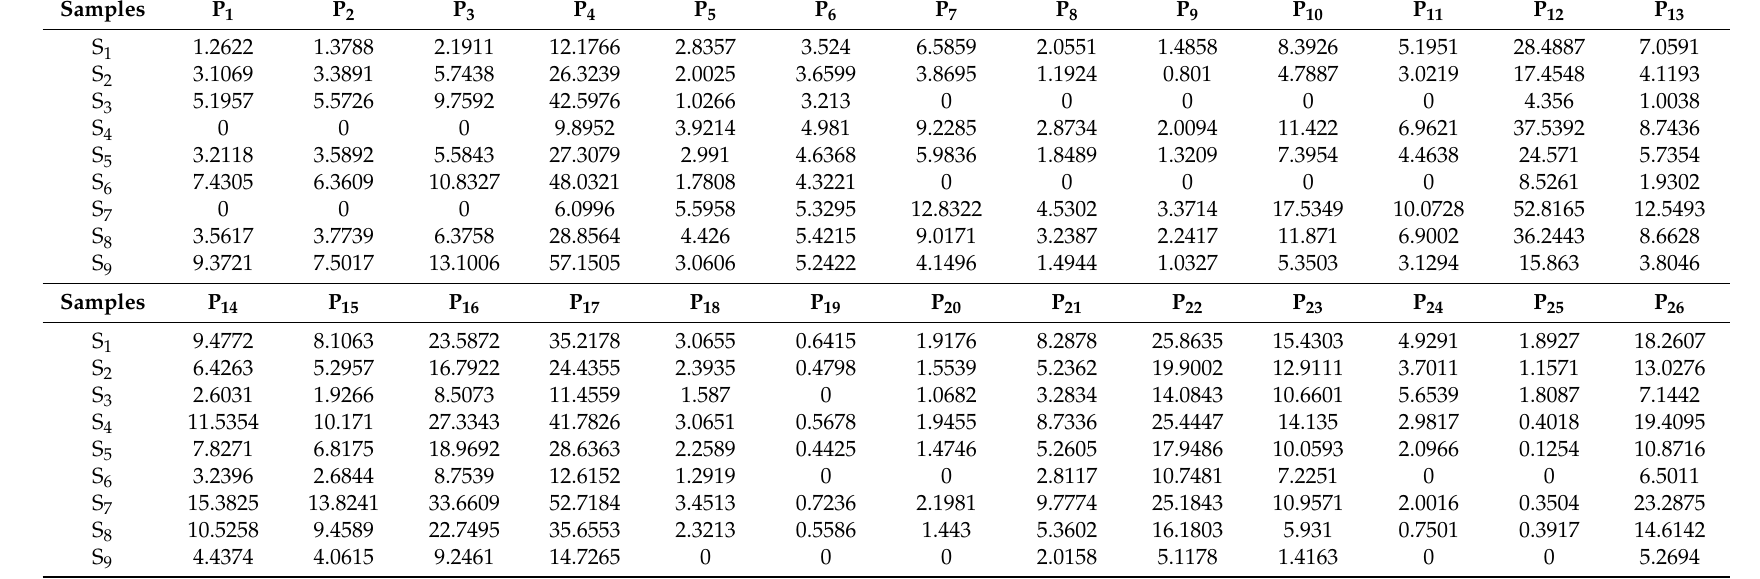
Table 2. The 26 peak areas of the nine GBE